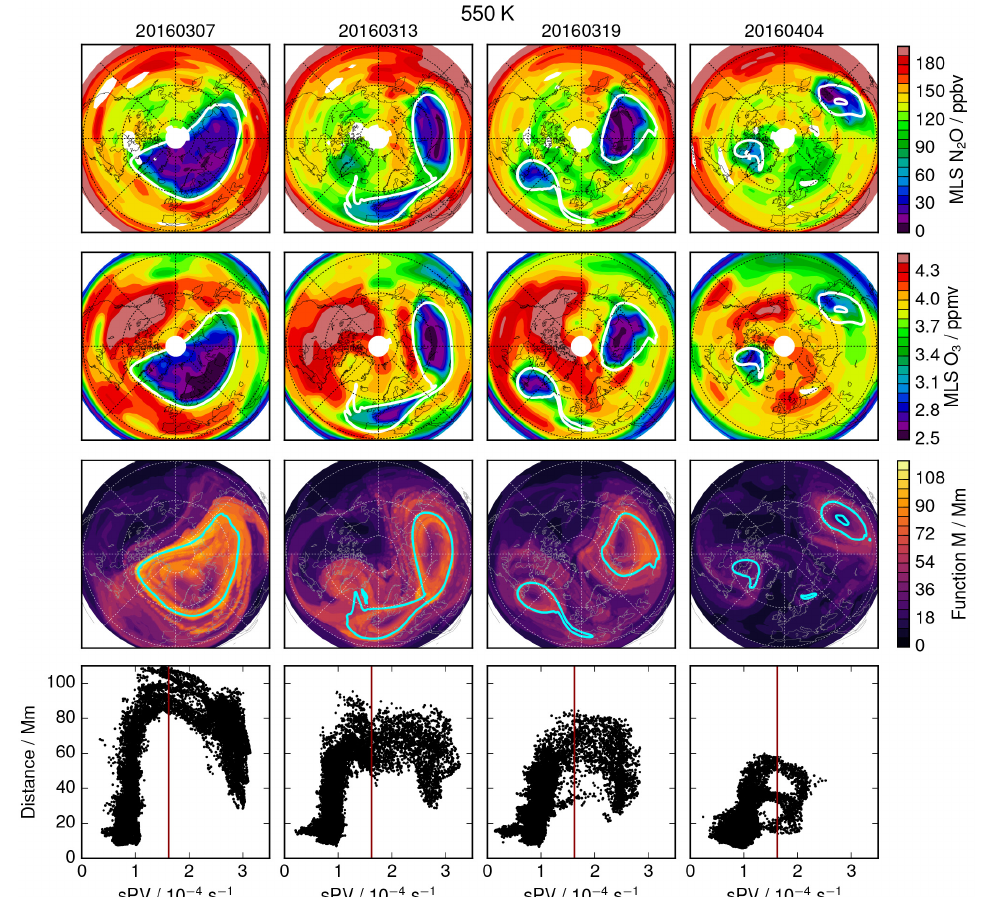
Figure 11. As in Fig. 10 but at 550K. Note that contour ranges are different than at